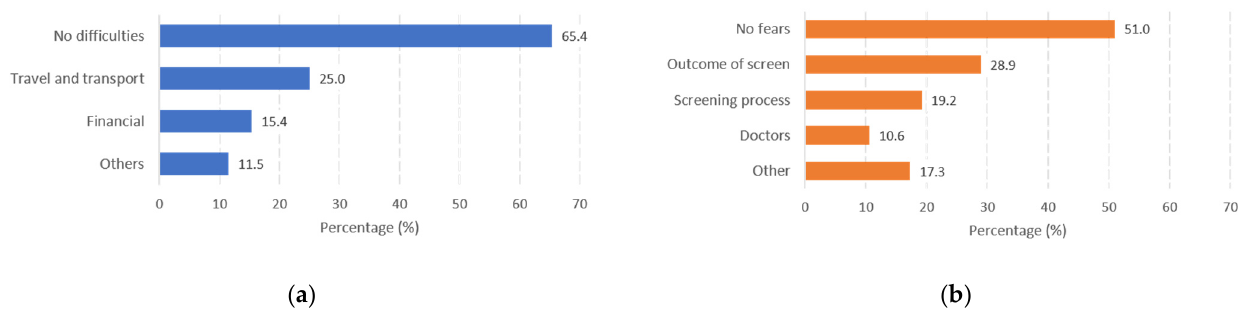
Figure 1. ( a ) Percentage of respondents reporting difficulties in accessing initial care; ( b ) percentage of respondents reporting fears towards the oral examination. Patients were allowed to choose more than one related factor.